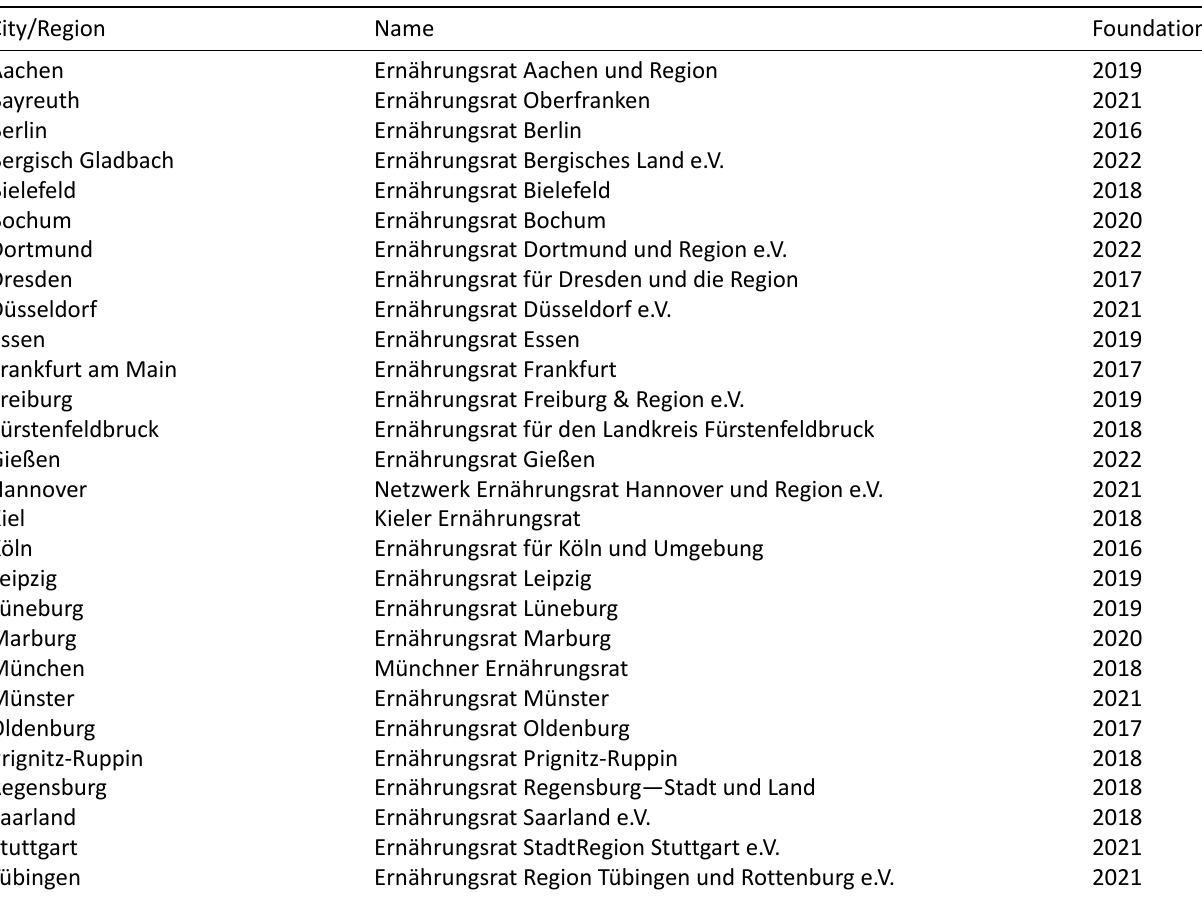
Table 1. FPCs in